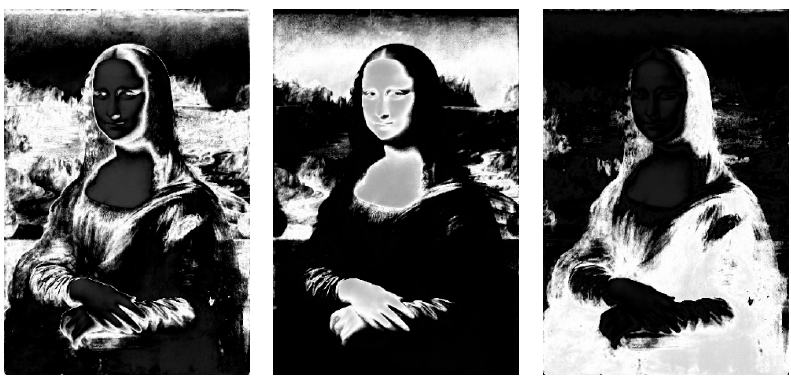
Figure 3. Mona Lisa R Band—compression rate 0.25—segmented images.